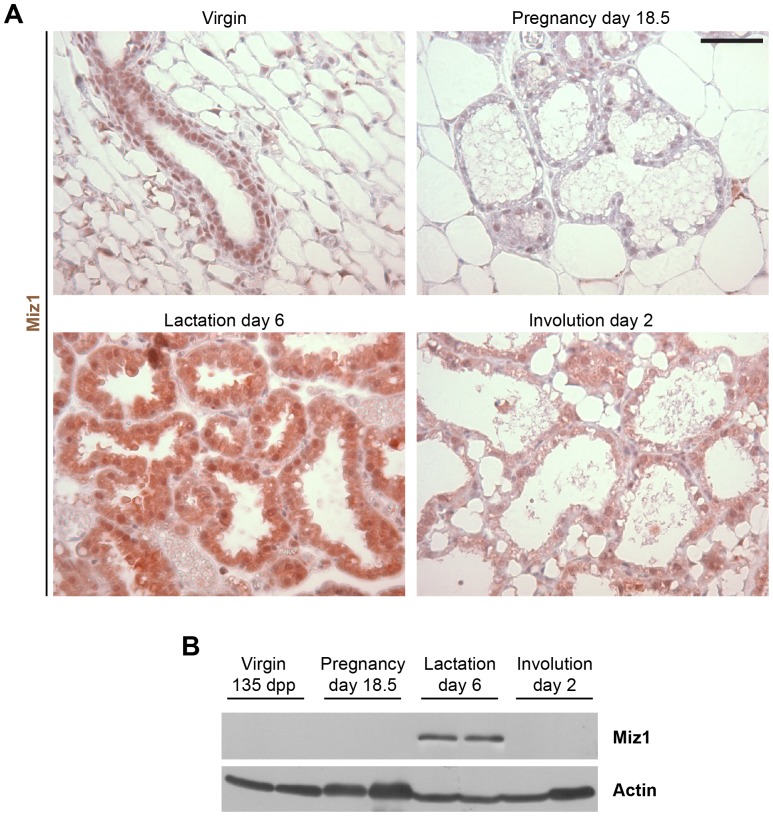
Miz1 expression in the mammary gland epithelium at different developmental stages.(A) Immunocytochemistry revealed a nuclear expression of Miz1 in the virgin gland as well as during pregnancy and involution. During lactation also a cytoplasmic staining was observed in addition to the nuclear stain. (B) Western blot analysis of Miz1 expression exhibited a strong Miz1 expression during lactation while the protein could only occasionally be detected in virgin gland. Scale bar in A: 50 µm.